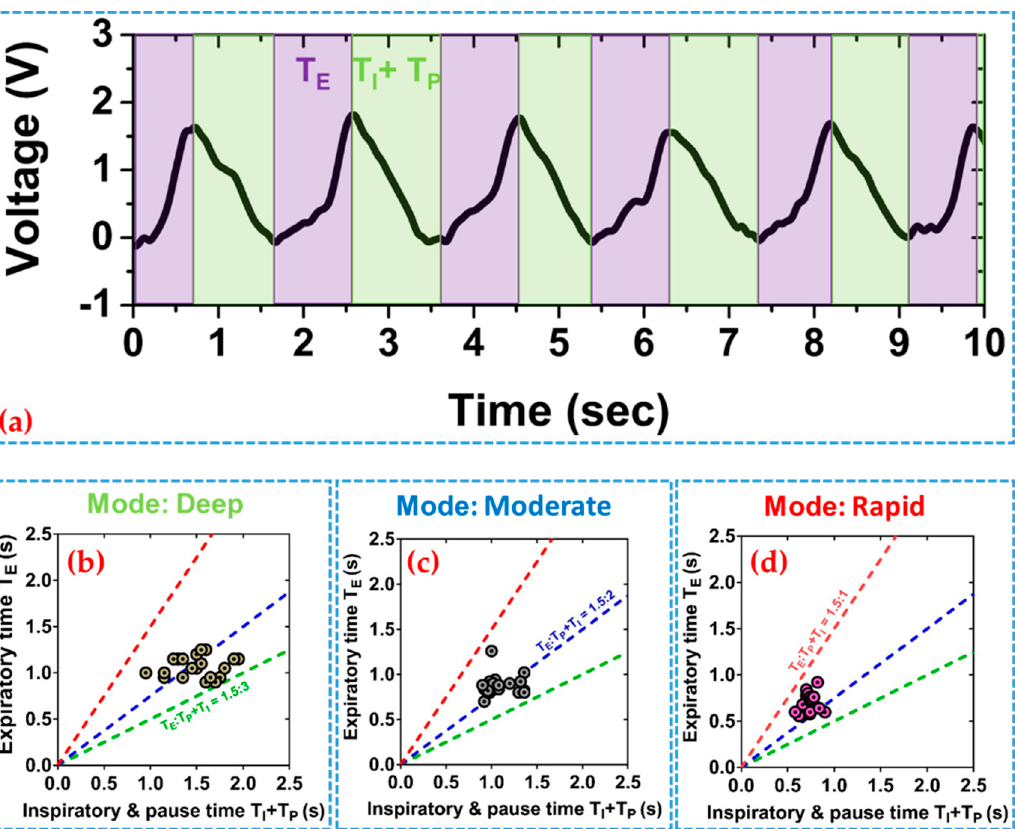
Figure 5. ( a ) Phase analysis of human respiration rhythm; relation of expiratory time and sum of inspiratory and pause time in during respiration mode of ( b ) deep, ( c ) moderate, and ( d ) rapid.